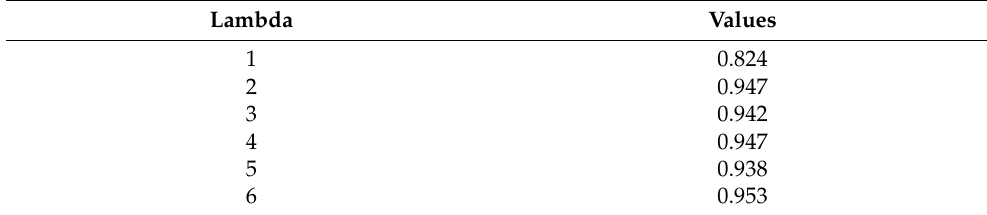
Table 6. Guttman’s reliability